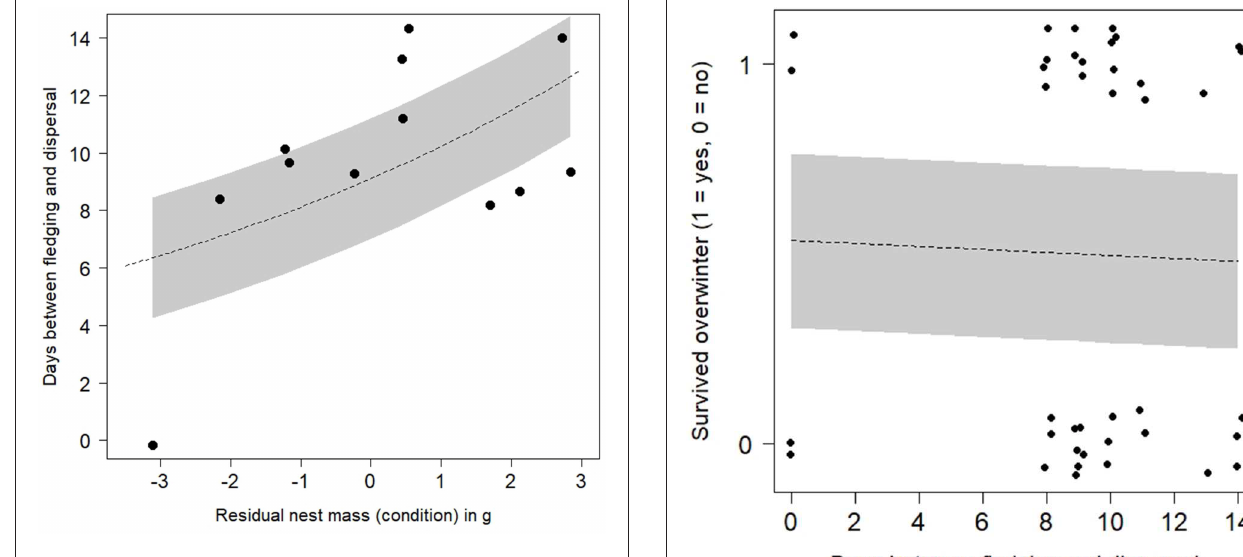
FIGURE 1 | Variation in the time it took for fledglings of N = 12 nests to disperse from their nest territories, depending on the average condition of nestmates (average of residual mass against tarsus length when 21 days old). Line of best fit and 95% confidence interval are predicted from a GLM exploring effects on dispersal timing (see Supplementary Table 1 ).